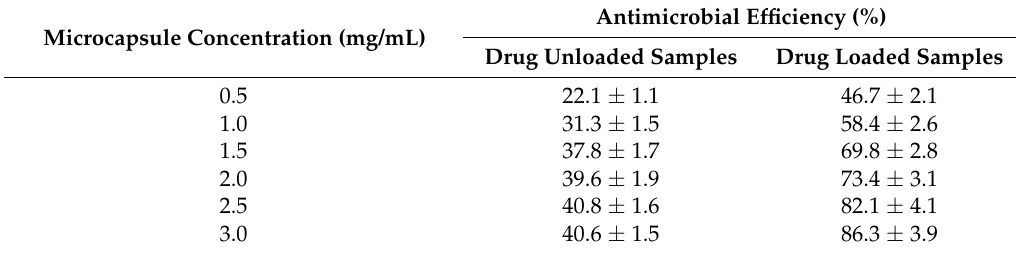
Table 1. Influence of microcapsule concentration on the antimicrobial efficiency of paper. Microcapsule Concentration (mg/mL)